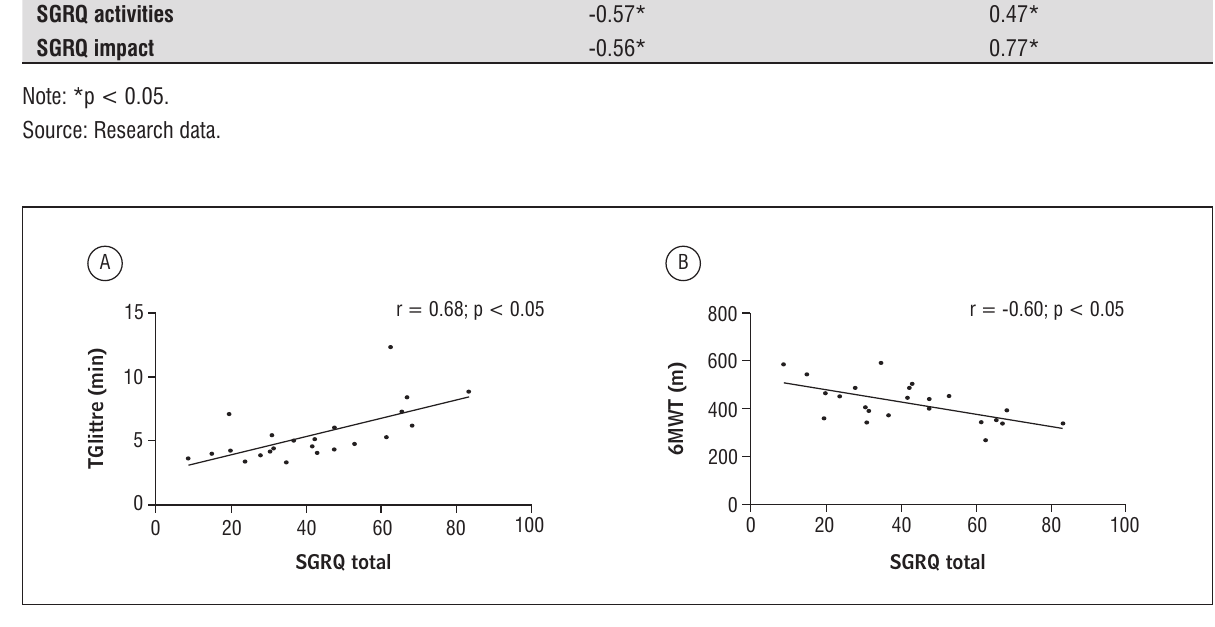
Table 3 - Correlation coefficient (r) between functional tests performance and quality of life domains 6MWT TGlittre SGRQ total -0.60* 0.68* SGRQ symptoms -0.42* 0.43* SGRQ activities -0.57* 0.47* SGRQ impact -0.56* 0.77*